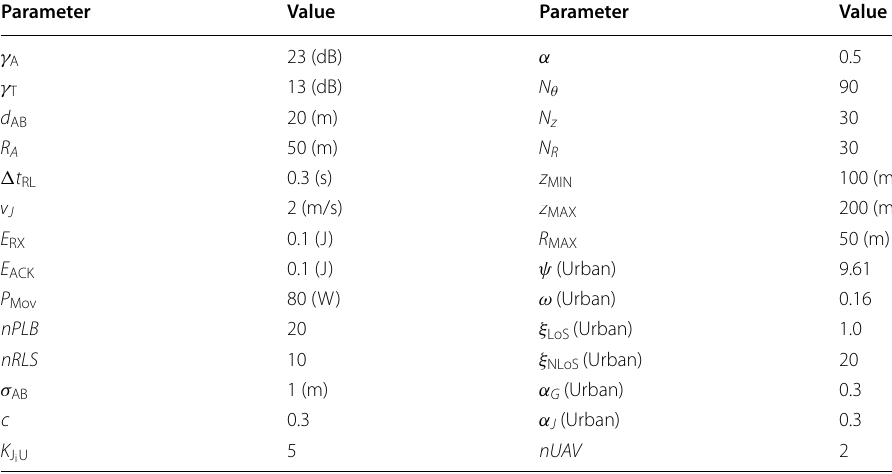
Table 1 Common simulation parameters